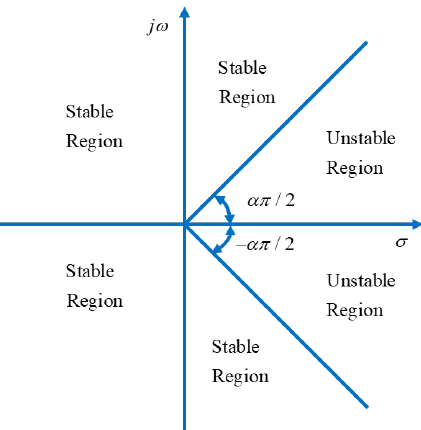
Figure 4. Stability regions of a fractional order